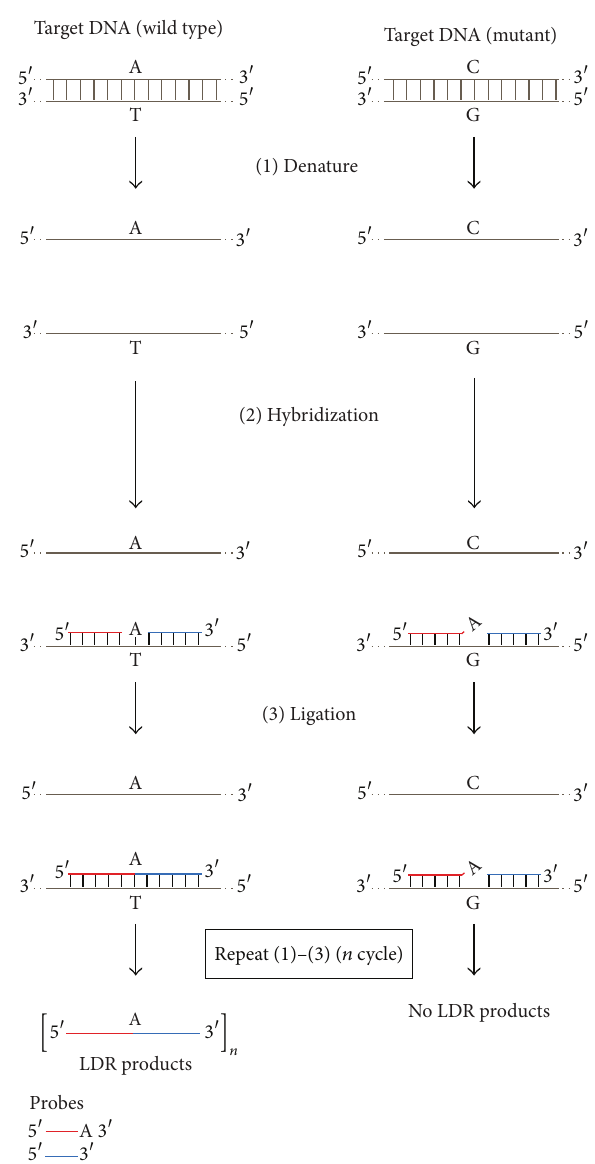
Figure 4: Schematic diagrams for the Ligation Detection Reaction (LDR) processes. DNA fragments from the normal type and the mutant type (at the single nucleotide polymorphism (SNP) site) are shown as reaction templates. (1) The denaturation process is the same as in Figure 3 (1). (2) Hybridization: two oligonucleotide probes, complementary to the normal-type target, hybridize to the target DNA fragment. (3) Ligation: adjacent probes that are perfectly complementary to the target (left) are connected by DNA ligase, and thermocycling linearly amplifies the amount of product formed. In the case of the mutant type template, the presence of a single-base mismatch at the junction inhibits the ligation, and therefore no ligated LDR probes are formed